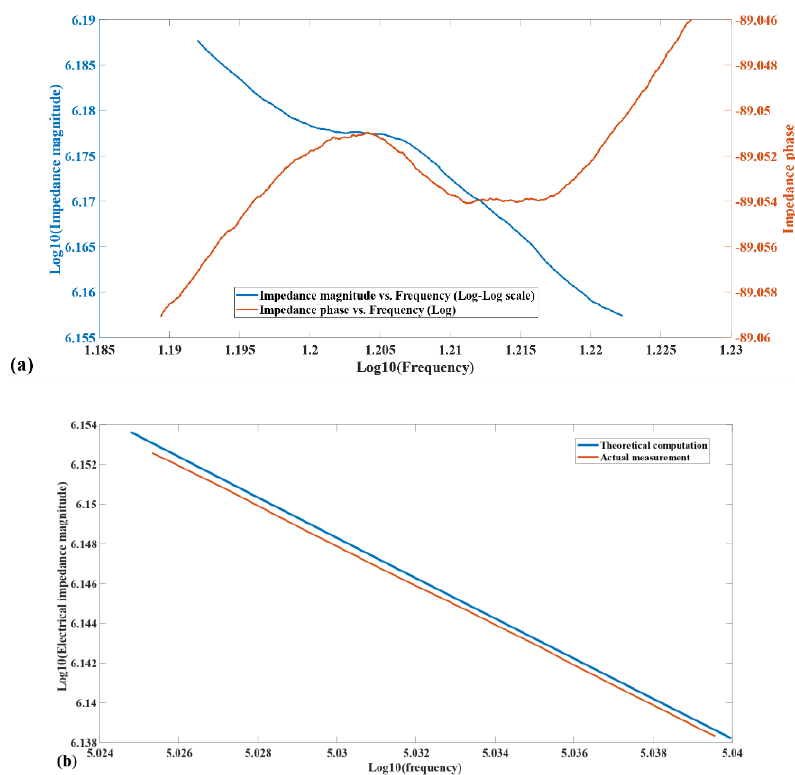
Figure 9. Electrical impedance characteristics of 60 in-plane test structures. ( a ) Impedance magnitude (log scale) vs. frequency (log scale) and Impedance phase vs. frequency (log scale) around the mechanical resonant frequency (around 16.25 kHz); ( b ) Impedance magnitude vs. frequency (log-log scale) away from the mechanical resonant frequency (16.86 kHz to 17.6 kHz).